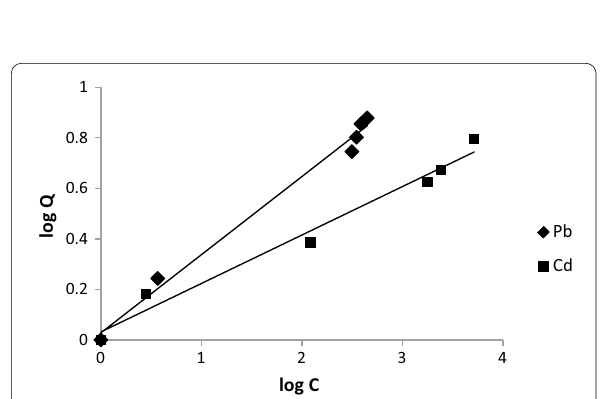
Fig. 6 Effect of volume of sample solutions on the recovery of Pb(II) and Cd(II) by modified Amberlite XAD-4 resin